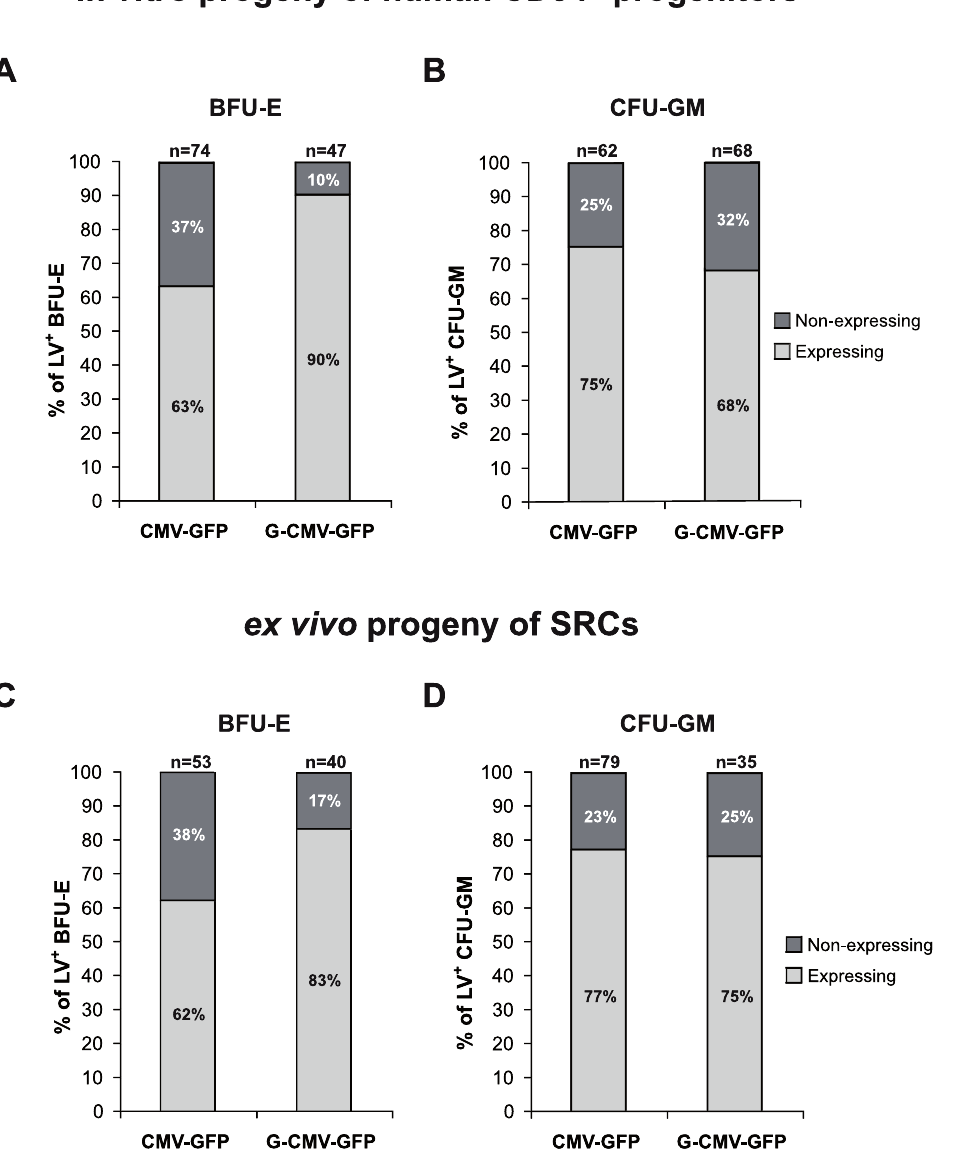
Figure 3. GATA1 -HS2 is able to sustain transgene expression in the erythroid compartment differentiating from human HPCs. (A–B) BFU-E and CFU-GM derived from CMV-GFP- and G-CMV-GFP-transduced CD34 + cells were scored by PCR for vector integration and for GFP expression under fluorescence microscopy. The percentages of GFP + (dark grey) and GFP 2 (light grey) colonies among the vector-containing BFU-E are represented (for each sample set, n is indicated above the corresponding bar). The proportion of vector-containing BFU-E that do not express the transgene is significantly higher for CMV-GFP compared to the percentage observed in G-CMV-GFP-transduced BFU-E (A; P , 0.005 Fisher exact test). (B) No significant difference in the proportions of GFP + CFU-GM was observed between the two groups. (C–D) NOD SCID mice were transplanted with CMV-GFP- and G-CMV-GFP-transduced CB-derived CD34 + cells. 8–11 weeks after transplantation mice were sacrificed and BM cells were ex vivo cultured in a medium allowing the growth of human erythroid and myeloid colonies. BFU-E and CFU-GM derived from CMV-GFP- and G-CMV-GFP- transduced SRCs (SCID repopulating cells) were scored by PCR for vector integration. The proportion of vector-positive BFU-E that do not express the transgene is higher for CMV-GFP vector compared to the percentage observed in G-CMV-GFP-transduced BFU-E (P , 0.05; Fisher exact test). The proportions of GFP + CFU-GM were similar for both vectors (P . 0.1).